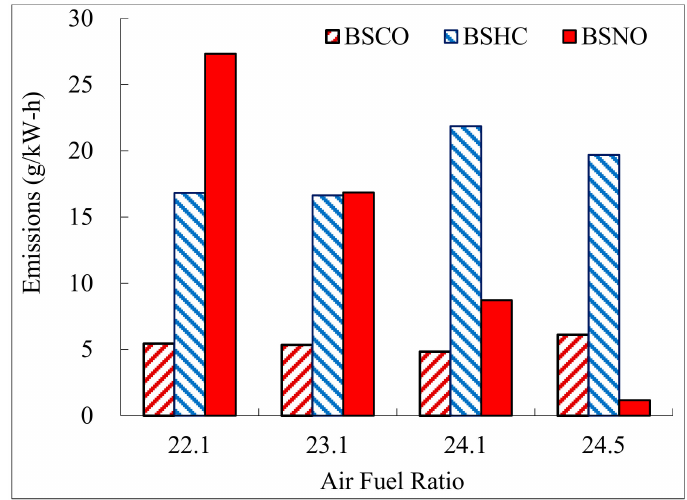
Figure 4. The influence of AFR on exhaust emissions. BSCO, BSHC, and BSNO denote brake-specific CO, HC, and NO emissions,